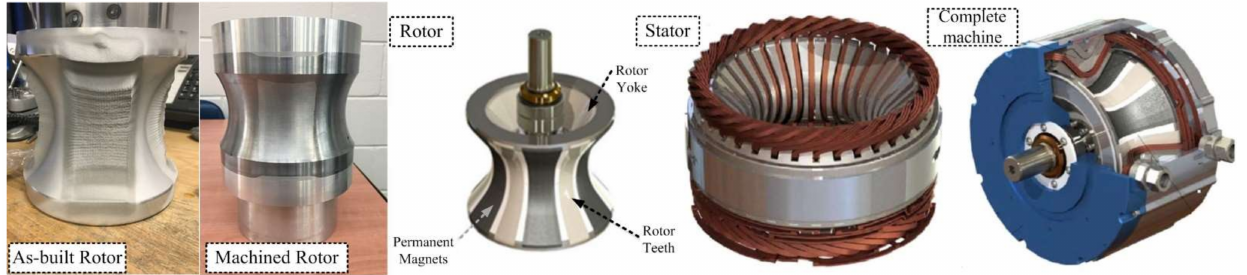
Figure 18. Additively manufactured PM rotor for a conical air-gap machine using cold spray technol- ogy